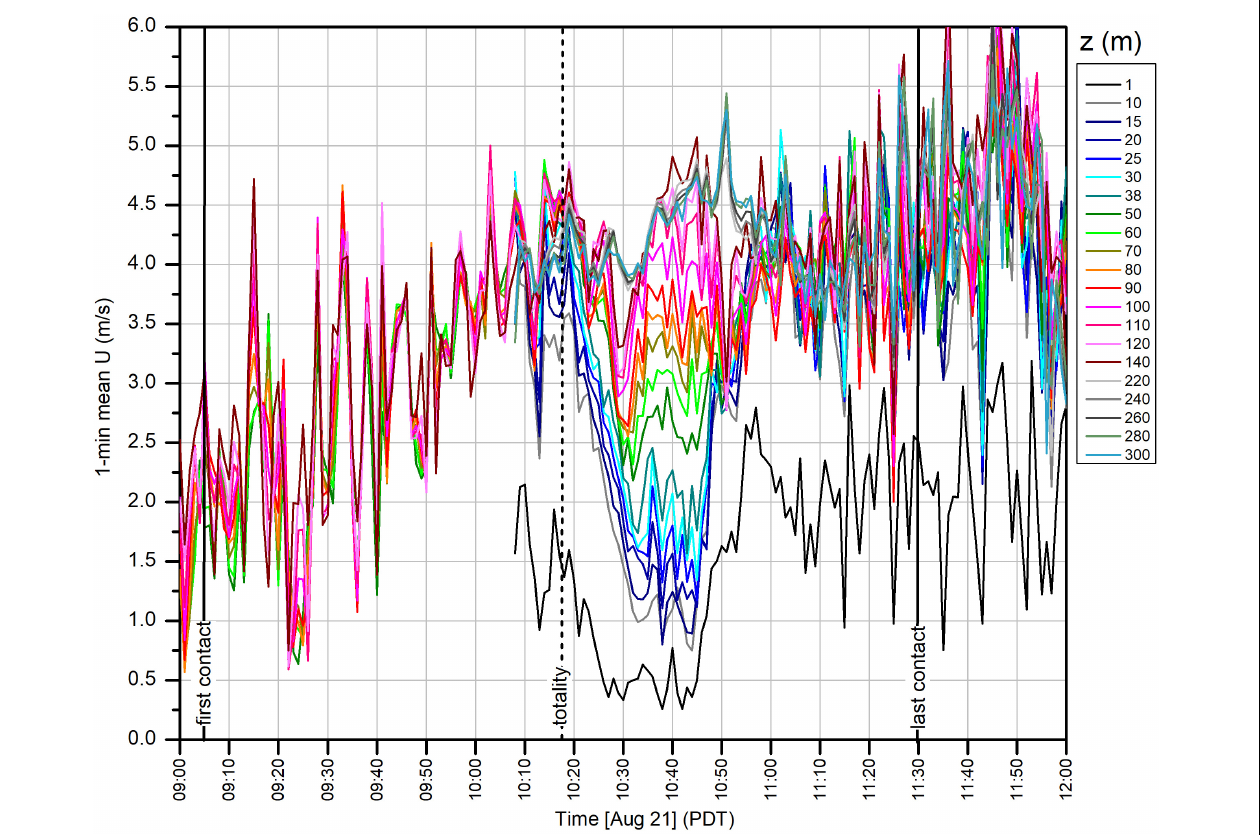
FIGURE 5 | Time trace of horizontal wind speed from 1 to 300 m measured by lidar. The data show significant shear following the eclipse which is most pronounced between 30 and 140 m. Note that due to lidar start up errors, the ZephIR300 did not start collecting data until just prior to